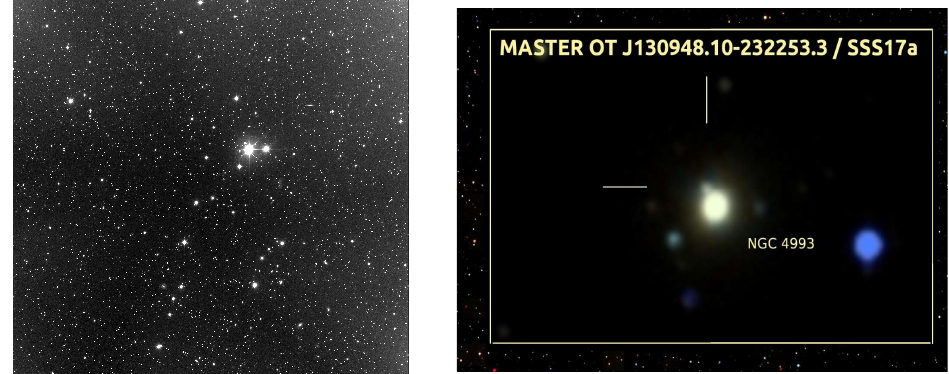
Figure 14. MASTER image of Kilonova (full frame and composed colored).